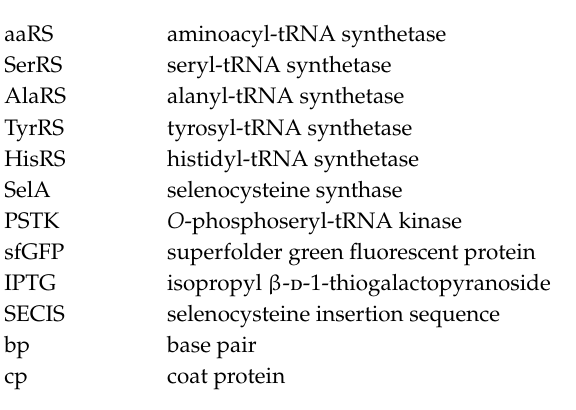
s1. Figure S1: Cloverleaf structures of the eight starting amber suppressor (9 / 3) allo-tRNA variants other than the S001 variant (Figure 1B), Figure S2: Ine ffi cient sequestration of allo-tRNA UTu1 (or S012), Figure S3: Sequestration of S012 derivatives, Figure S4: Examining synthetic tRNA His variants, Figure S5: A preliminary screening experiment of several cognate pairs of RNA aptamers and binding protein domains towards enhancing the histidylation activity, Figure S6: Cm resistance of E. coli DH10B (NEB 10-beta) cells expressing the cat(His193TAG) reporter gene and the indicated combinations of HisRS and tRNA variants, Table S1: Screening of candidate chassis tRNAs by using E. coli DH10B cells expressing the cat(Ser146TAG) reporter gene on growth media containing chloramphenicol (Cm) at a fixed concentration of 34 µ g /